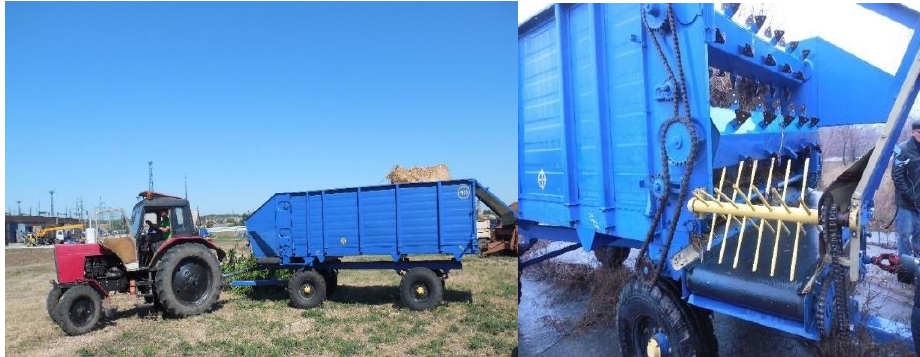
Figure 1. General view of equipment for the technological process of making straw bedding with rotary finger working bodies (for clarity and complete display of the drive and the working body, the protective barriers were dismantled at the time of photo-fixation).